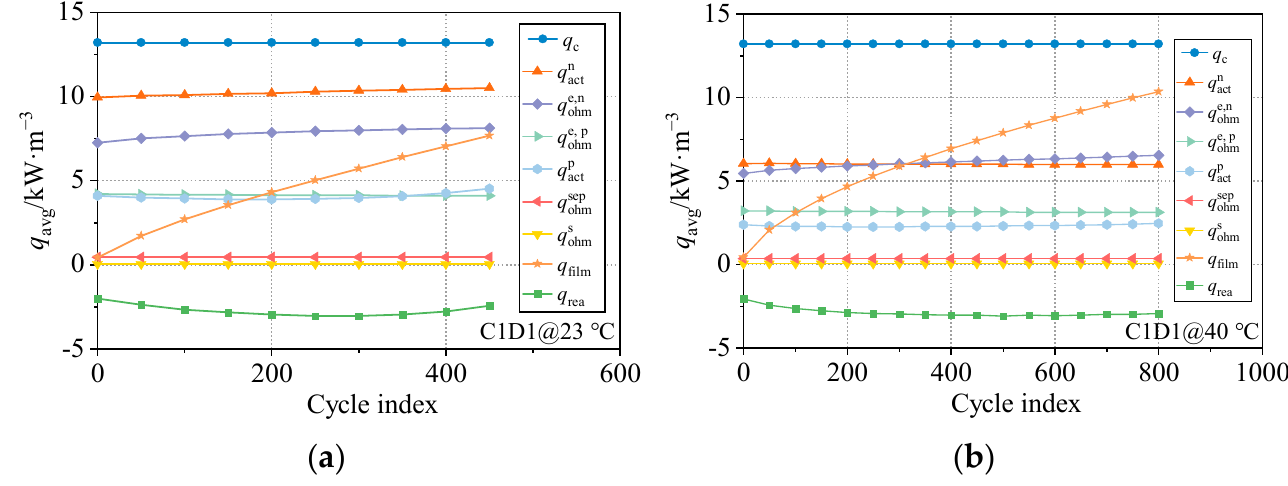
Figure 8. Variation in heat generation power for different components during cyclic aging at ( a ) 23 °C and ( b ) 40 °C.